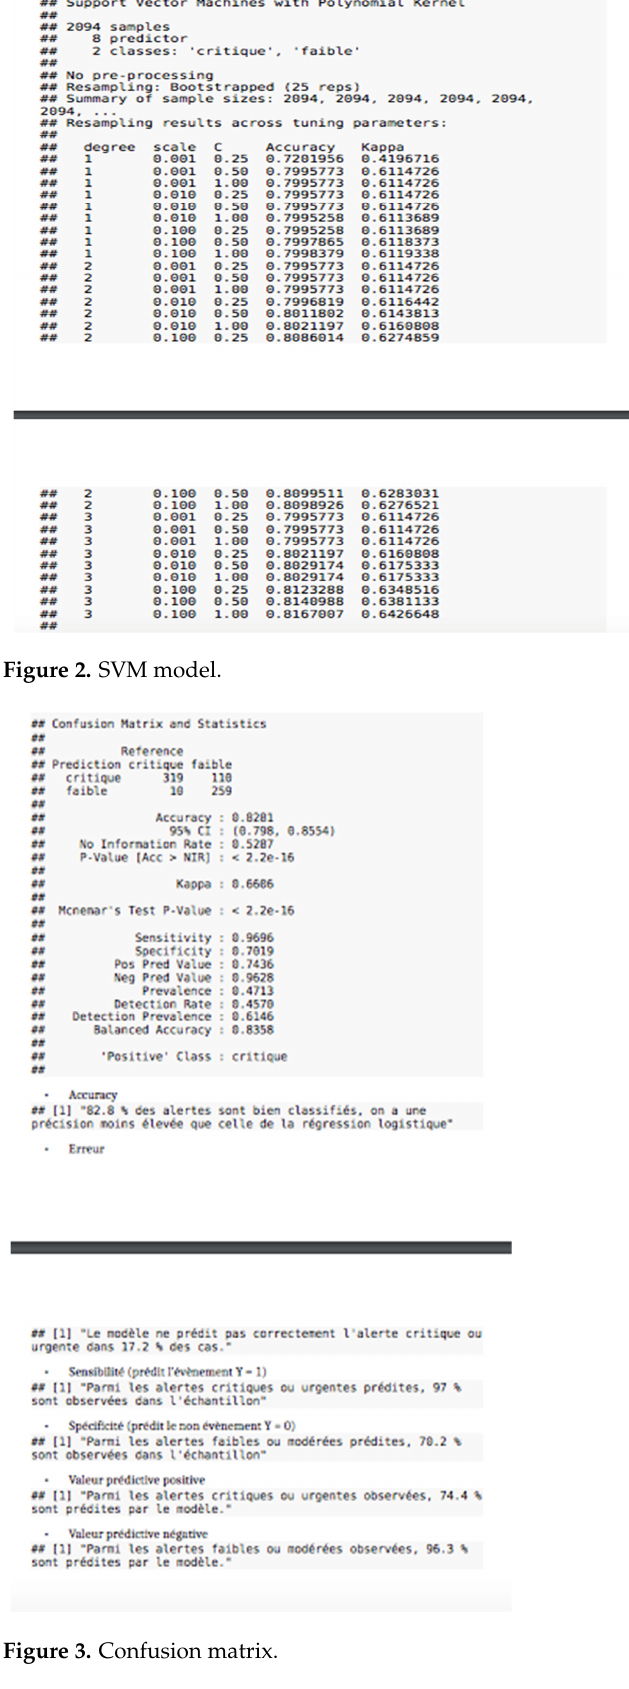
Figure 3. Confusion matrix.